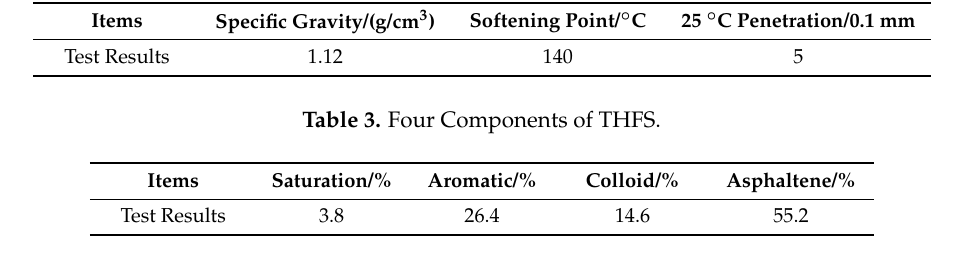
Table 2. Physical Properties of tetrahydrofuran soluble fraction (THFS).